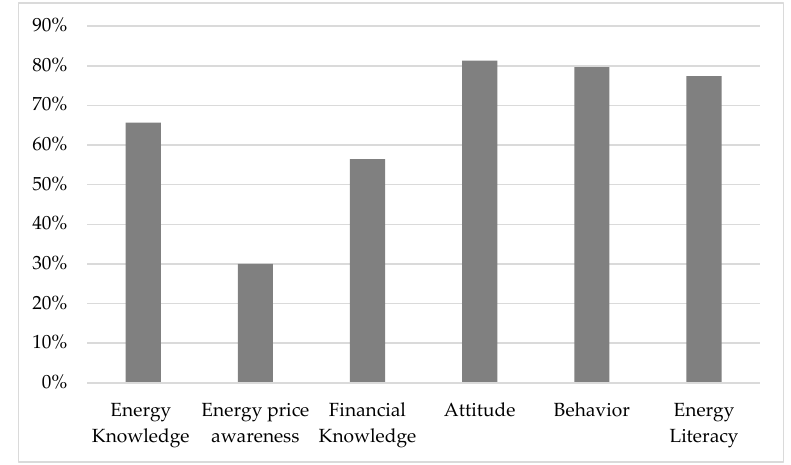
Figure 1. Energy and financial knowledge, energy price awareness, attitude, behavior and energy literacy levels.